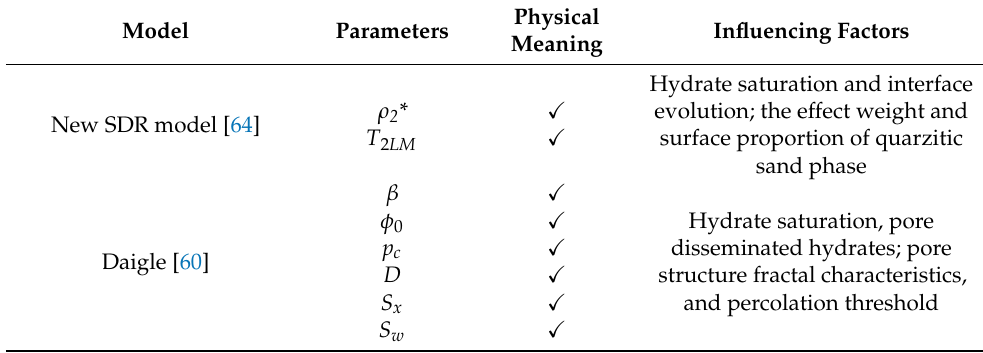
Table 8. Characteristics of novel permeability models for permeability prediction of